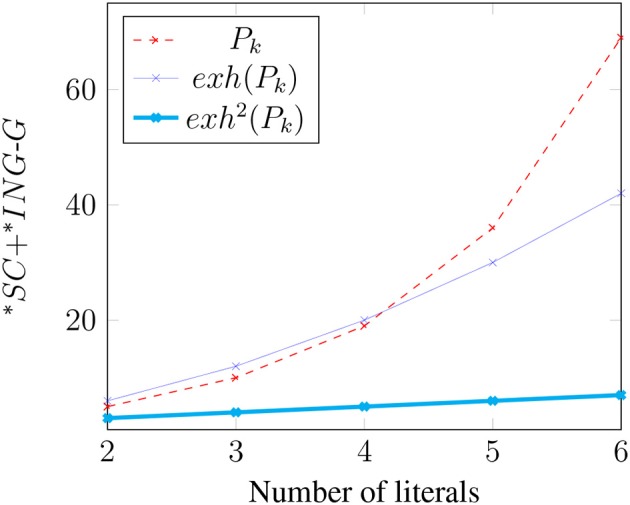
Cost of update (to be revised).